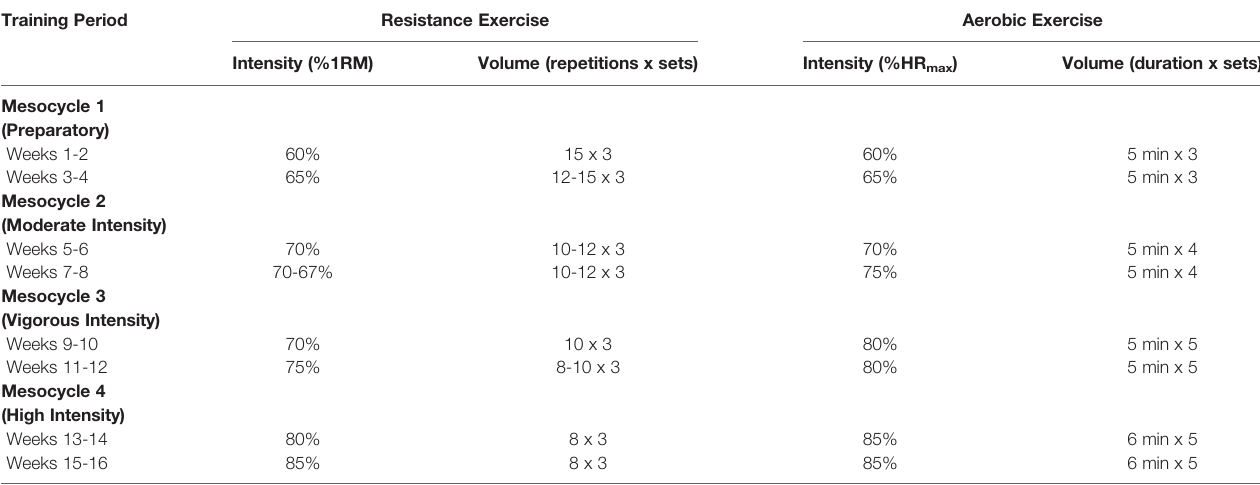
TABLE 2 | Periodization model for exercises in the CARE